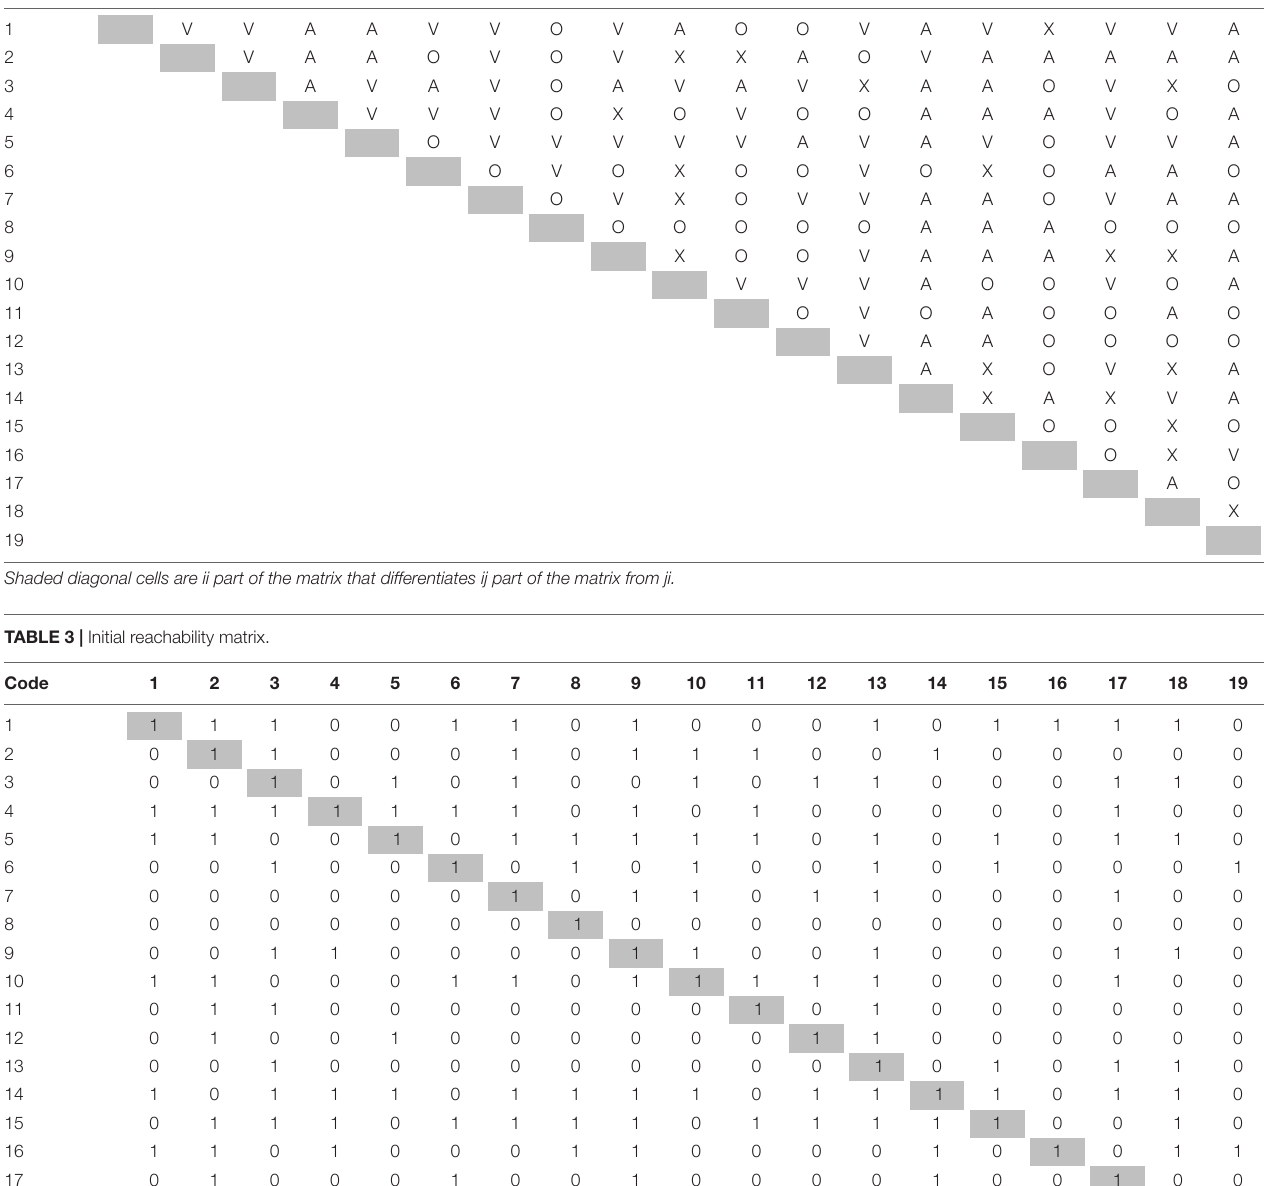
four clusters ( Figure 2 ): autonomous cluster: factors with low driving and dependence powers, separated from the